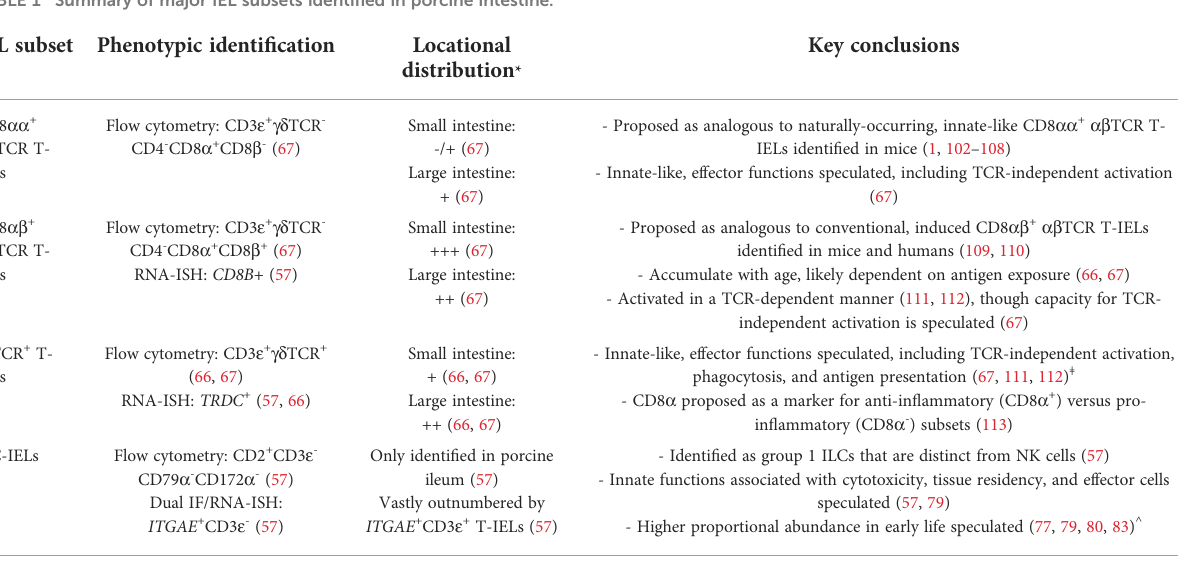
TABLE 1 Summary of major IEL subsets identi fi ed in porcine intestine.